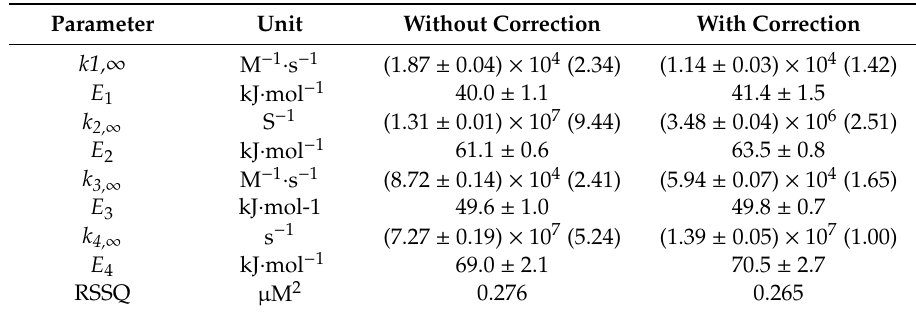
Table 4. Parameter estimates for set 3 (n-propanol as solvent). For the pre-exponential factors, the deviation is indicated between brackets.